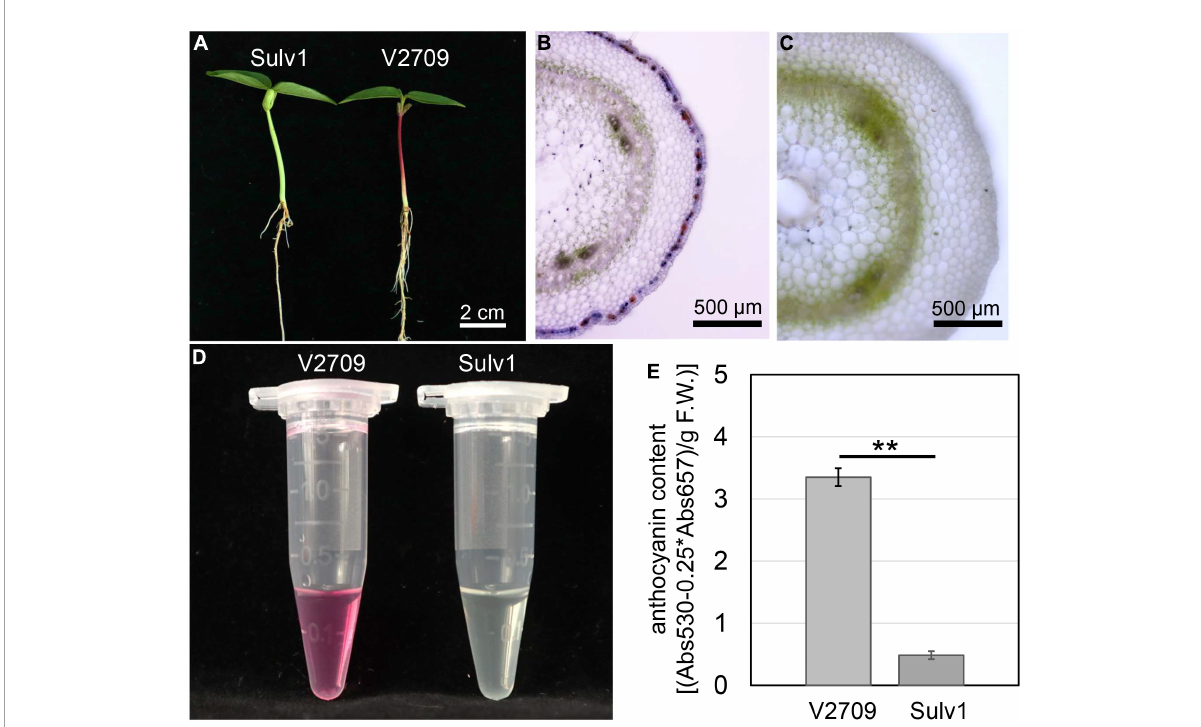
FIGURE1 Phenotypes of purple- and green-hypocotyl parental genotypes. (A) Green-hypocotyl genotype (Sulv1) and purple-hypocotyl genotype (V2709). (B) Transverse section of V2709 hypocotyl. (C) Transverse section of Sulv1 hypocotyl. (D) Fresh extracts from hypocotyls of V2709 and Sulv1. (E) Total anthocyanin contents of V2709 and Sulv1 hypocotyls. **Indicates a significant difference by Student’s t -test ( P < 0.01).